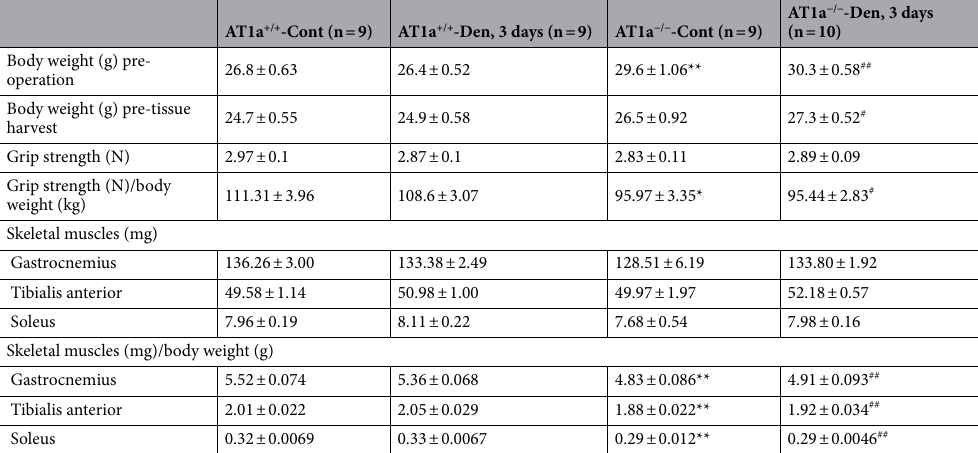
Table 2. Animal characteristics at 3 days postdenervation. Values are means ± SE. * P < 0.05 and ** P < 0.01 vs AT1a +/+ -Cont; # P < 0.05 and ## P < 0.01 vs AT1a +/+ -Den (3